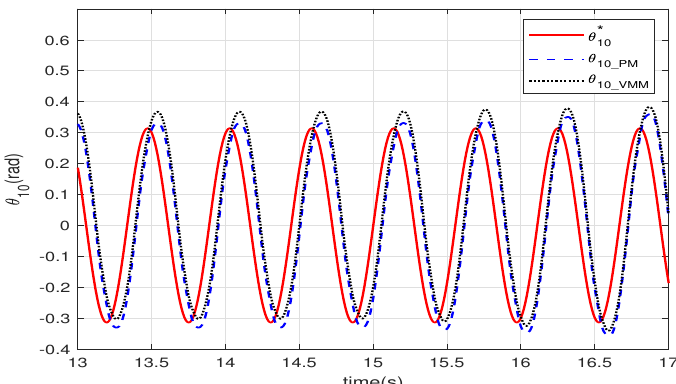
Figure 7. The angle of the first joint. The angular velocity of the tail relative to the head is illustrated in Figure 8. The angular velocity of VMM ( ˙ θ 21_VMM ) changes more smoothly than that of PM ( ˙ θ 21_PM ). The virtual spindle model in the VMM adjusts the torque according to the angle and the angular velocity of the joints. This adjustment mimics how the muscles change the stretching speed and power to improve the smoothness of the movements.